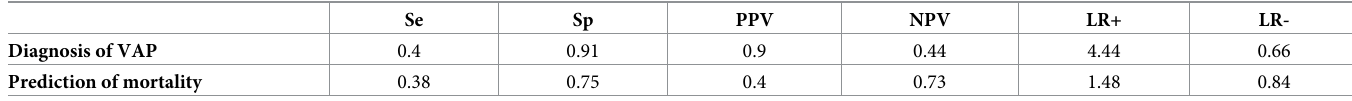
Table 3. Performances of sepsis criteria according to Sepsis-3 for the diagnosis of VAP and the prediction of ICU mortality in patients with VA-LRTI.